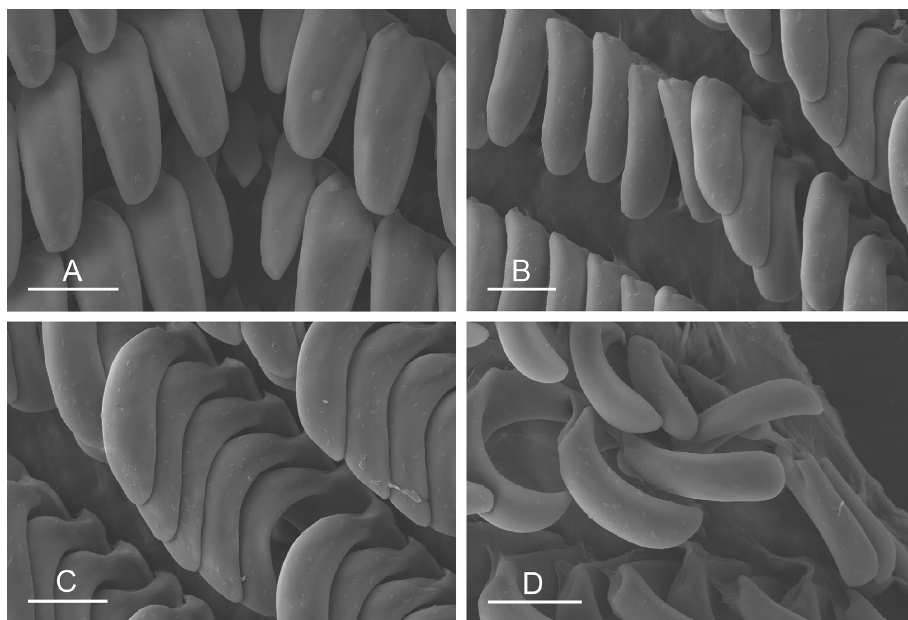
Figure 31. Radula, Wallaconchis nangkauriense , Indonesia, Bali [3129] (UMIZ 00020). A Rachidian and innermost lateral teeth, scale bar 20 μm B Innermost lateral teeth, scale bar 20 μm C Outer lateral teeth, scale bar 20 μm D Outermost lateral teeth, scale bar 20